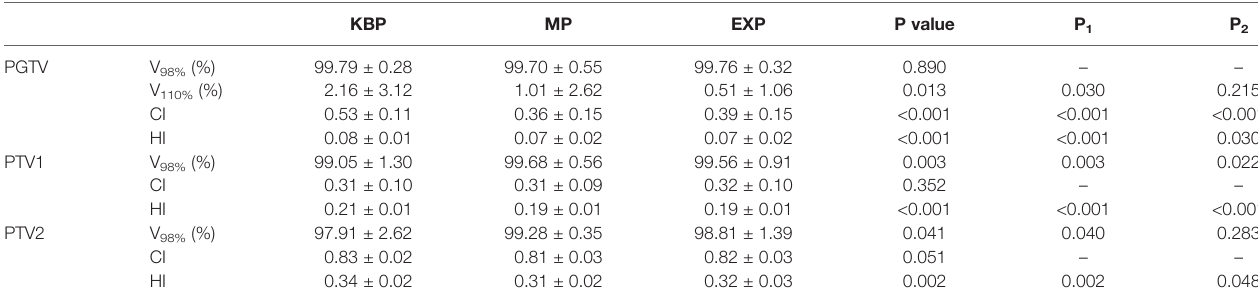
P 1 represents KBP vs MP, P 2 represents KBP vs EXP.